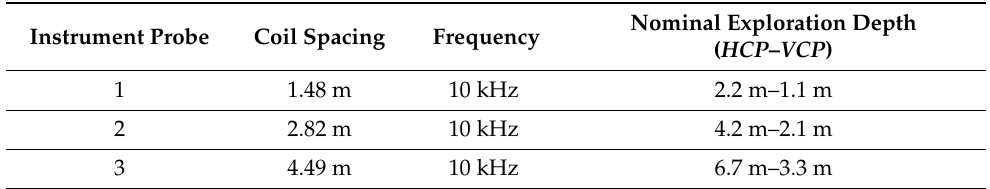
Figure 4. Picture taken during the FDEM measurements performed on the Murfreit rock glacier. “Start” was the position of the first electrode and “end” the position of the last electrode. Note that the measured FDEM transect is the same where the ERT survey was previously executed. Table 2. Technical specifications of the multi-coil CMD Explorer FDEM (gf-instruments.cz).